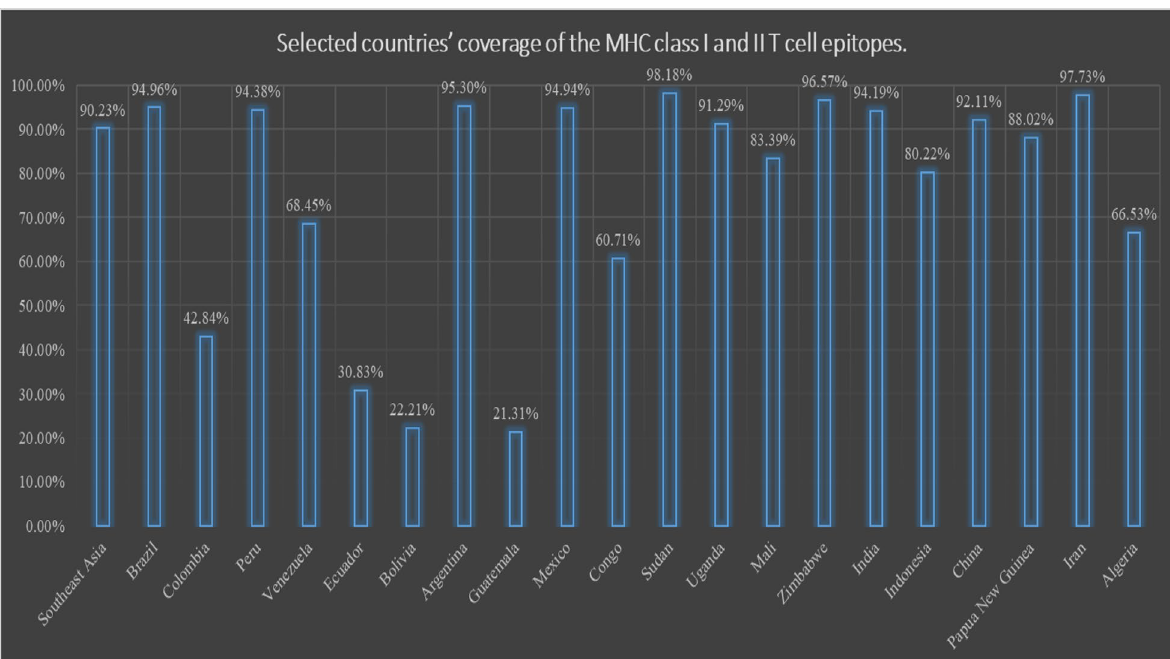
Fig. 3 Population coverage of T cell epitopes with their HLA alleles against the hotspots of